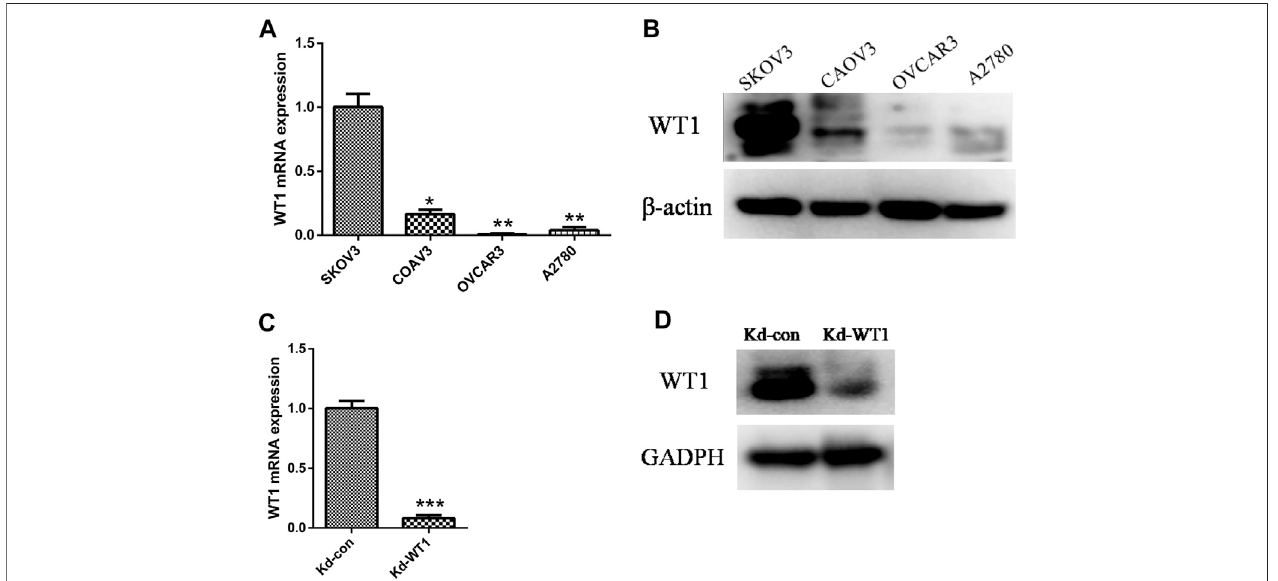
FIGURE2| WT1knockdownintheovariancancercelllineSKOV3. (A,B) qRT-PCRandWesternblottingtodetecttheexpressionofWT1infourovariancancercell lines(SKOV3,Coav-3,OVCAR3,A2780), β -actinactsascontrol. (C,D) qRT-PCRandwesternblottingwereusedtodetecttheexpressionofWT1intheSKOV3cellline after siRNA transfection, GAPDH used as control. * p < 0.05, ** p < 0.01, *** p < 0.001. Kd: knockdown.